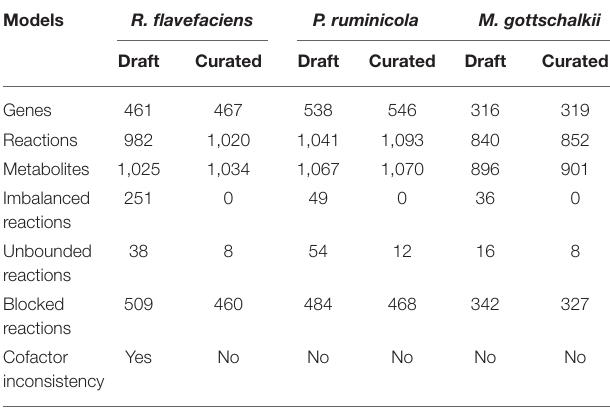
TABLE 1 | Statistics for the draft and curated models of R. flavefaciens, P. ruminicola , and M. gottschalkii .